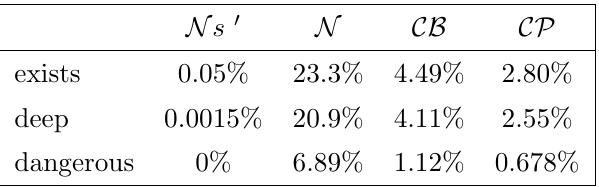
Table 3 . Percentage of phenomenologically viable points that have a second minimum in addition to an EW vacuum of type N s . In the (cid:12)rst line we present the percentage of coexisting minima, in the second line the ones that are deeper and in the third line the dangerous , short-lived, ones. The minima of type N s 0 have VEVs like those of N s but such that v 6 = 246 GeV, and di(cid:11)er from the EW vacuum in